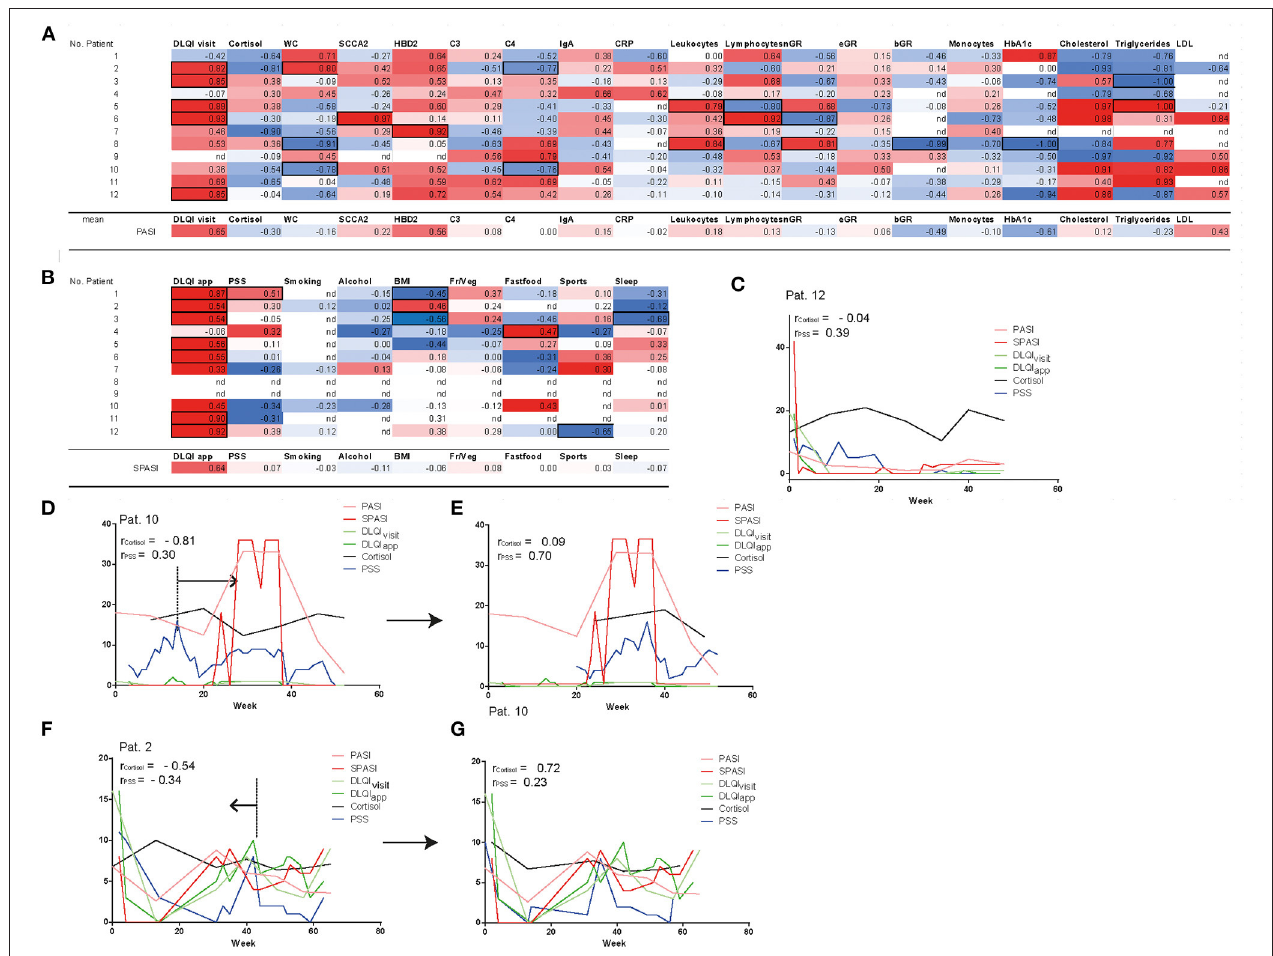
FIGURE 3 | Correlation of disease severity with parameters assessed at outpatient visits and via app. PASI shows correlation with DLQI visit and HBD2 (A) , SPASI with DLQI app (B) . Significance of parameters ( p < 0.01) on patient level are shown in black frames. Besides, mean correlation coefficients of all patients are shown for each parameter with PASI/SPASI. Nd = no correlation could be calculated. Fr/Veg = consumption of fruits and vegetables. Curves of cortisol, PSS, DLQI visit , DLQI app , PASI, and SPASI are exemplarily shown in patient 12 (C) , patient 10 (D,E) , and patient 2 (F,G) and reveal temporal correlation of stress and PASI. In patients 10 and 2, curves of PSS and cortisol are timely shifted (E,G) to reveal PSS and cortisol as factors temporally preceding (D) or succeeding (F) increase of PASI. nGR, neutrophils, eGR, eosinophils; bGR, basophils; Fr/Veg, consumption of fruits and